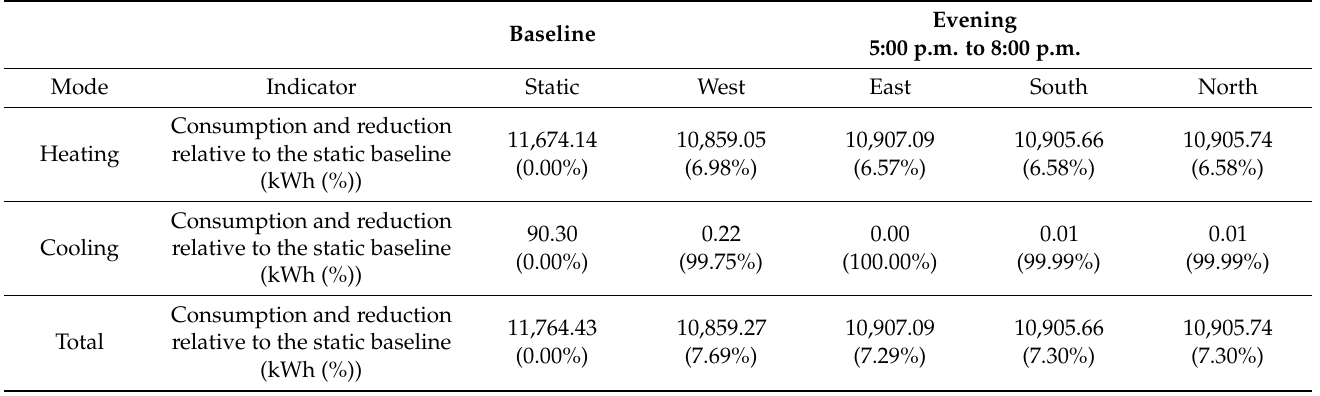
Table 15. Comparison of annual space heating and cooling energy consumption when a single window of the prototypical detached house model is forced open during the